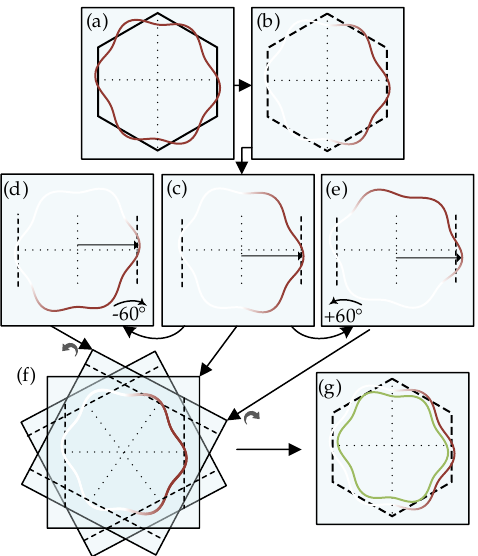
Figure 4. Trajectory rotation process example. ( a ) Full-trajectory. ( b ) Half-trajectory. ( c ) Trajectory comparison with left and right edges. ( d ) and ( e ) Comparison of rotated trajectory ( ± 60 ◦ ). ( f ) Trajectory rearrangement to get the full hexagon. ( g ) Optimal k S is